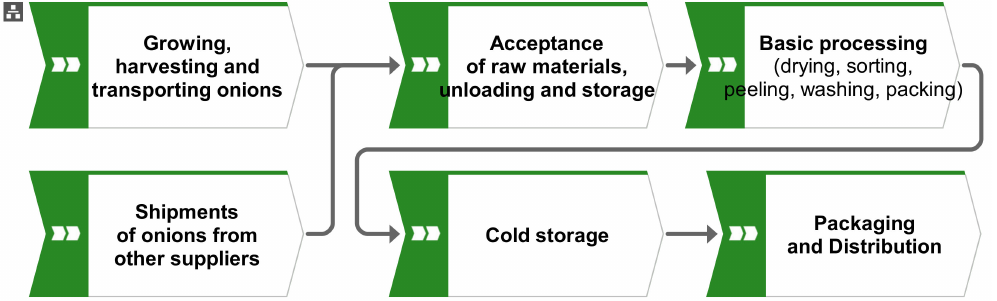
Figure 3. General stages of the onion production